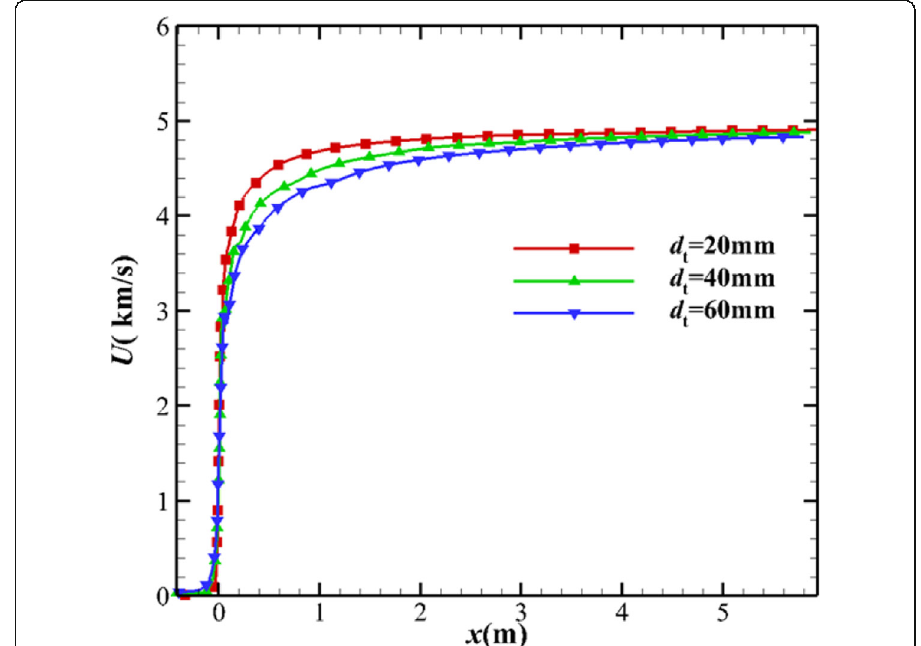
Fig. 10 Comparison of centerline velocity distributions based on the different throat diameter